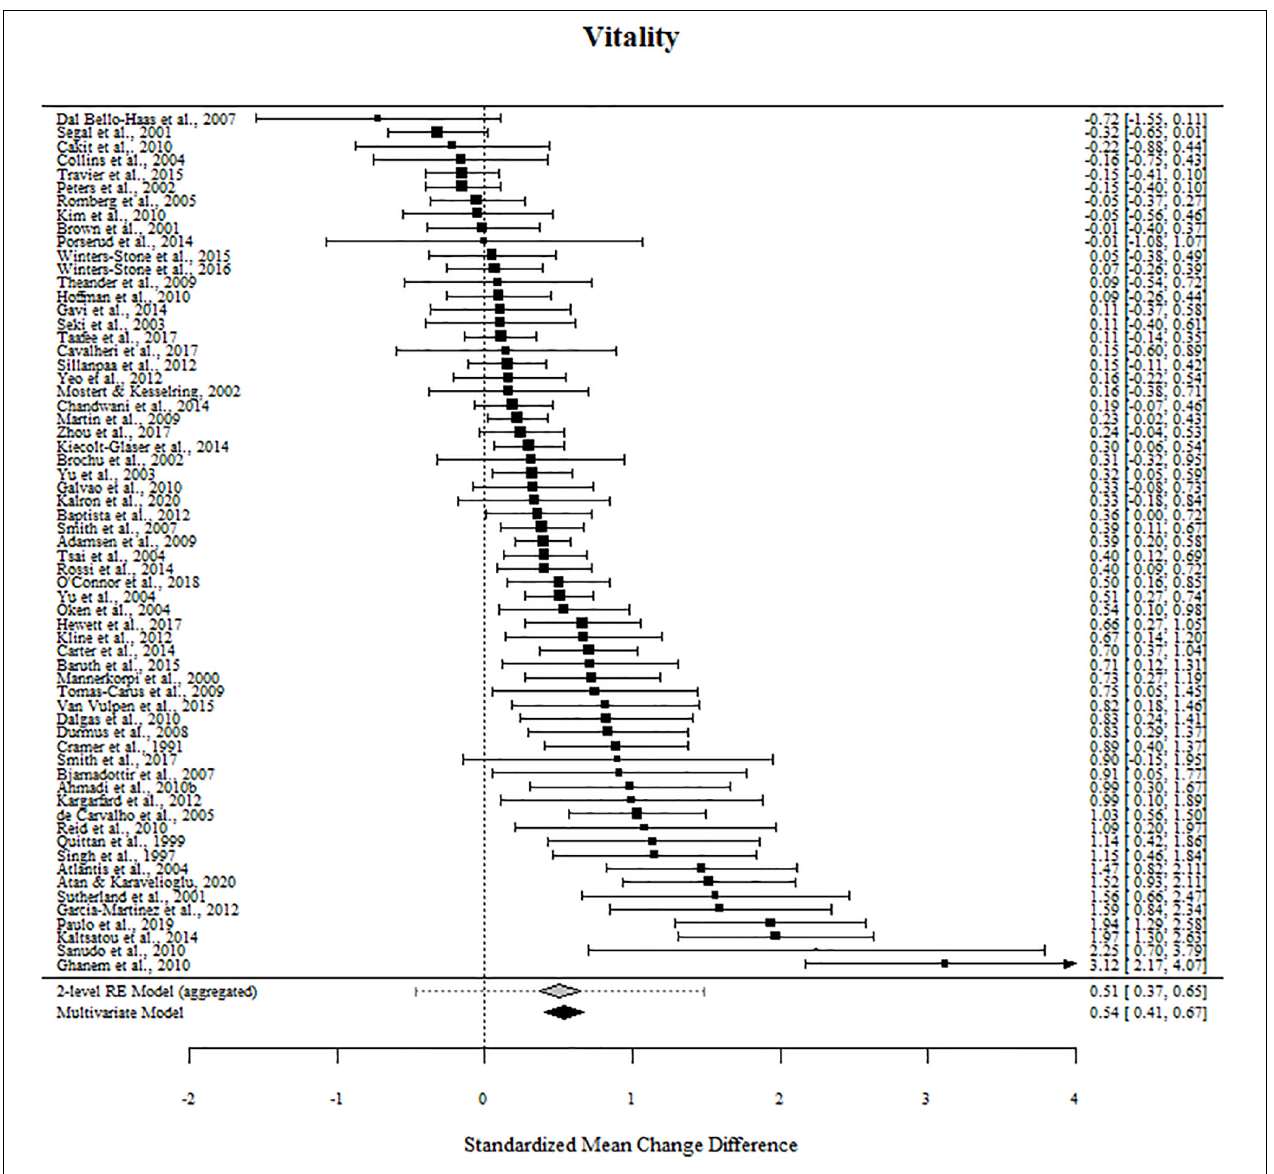
FIGURE 5 | Forest plots for vitality. Aggregated study effects displayed with a mean estimate coming from a meta-analytic model and a two-level random effects model for comparison